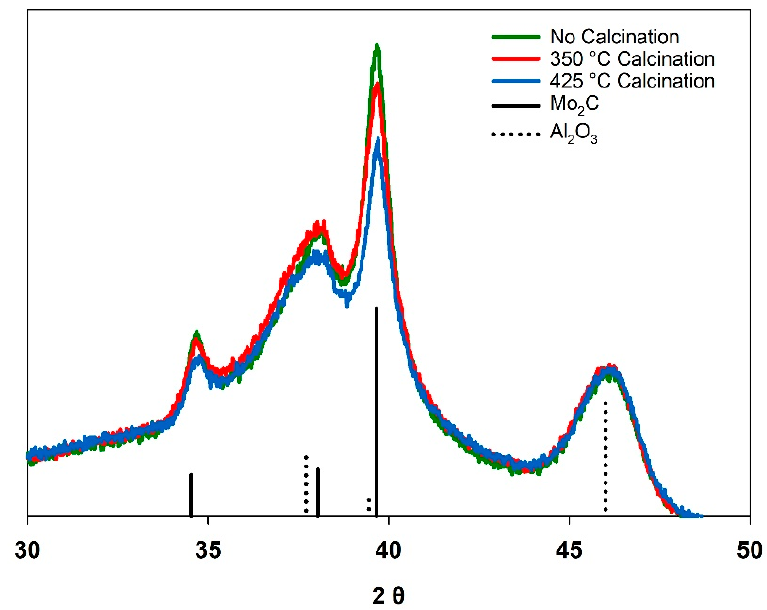
Figure 2. Normalized X-ray diffraction patterns for K-Mo 2 @ γ -Al 2 O 3 prepared at different calcination temperatures. Table 2. RWGS activity for K-Mo 2 C@ γ -Al 2 O 3 prepared using different calcination temperatures. All